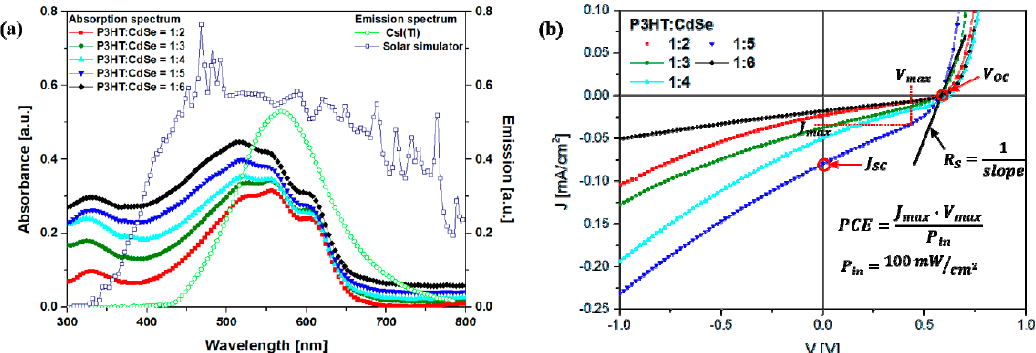
Figure 4. ( a ) The absorption spectrum for P3HT:CdSe QD thin films with different blending ratios of 1:2, 1:3, 1:4, 1:5, and 1:6 and emission spectra for CsI(Tl) scintillator under X-ray irradiation, and ( b ) J–V characteristics of the proposed detectors with di ff erent blending ratios of P3HT:CdSe QDs obtained under artificial solar